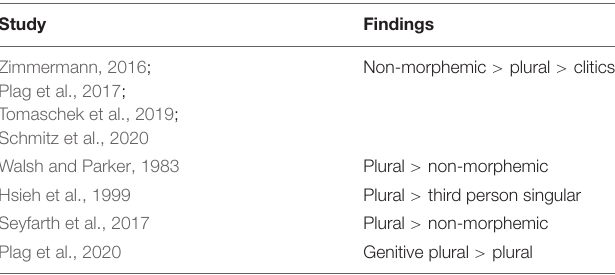
TABLE 1 | Overview of durational differences of word-final /s/ found in previous studies. Study